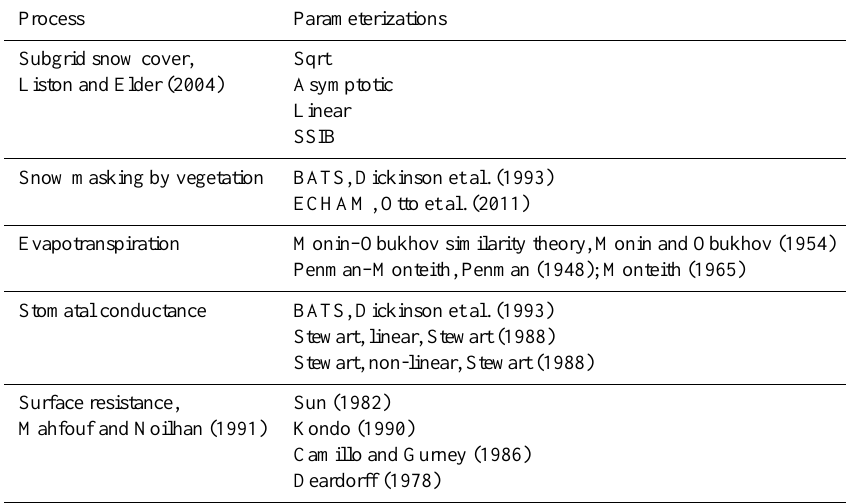
Table 1. Parameterizations for different biogeophysical processes included in the model ensemble.